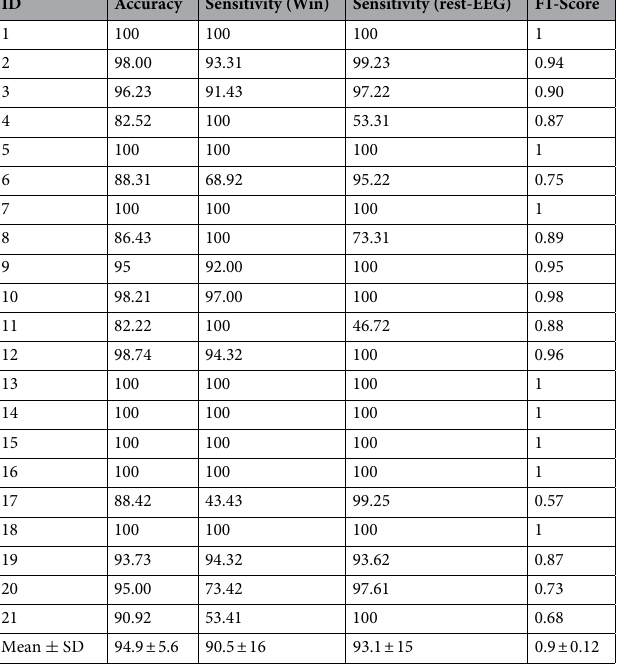
Table 3. The accuracy and sensitivity of Win and rest-EEG classes, and F1 score results for each participant for task 3.